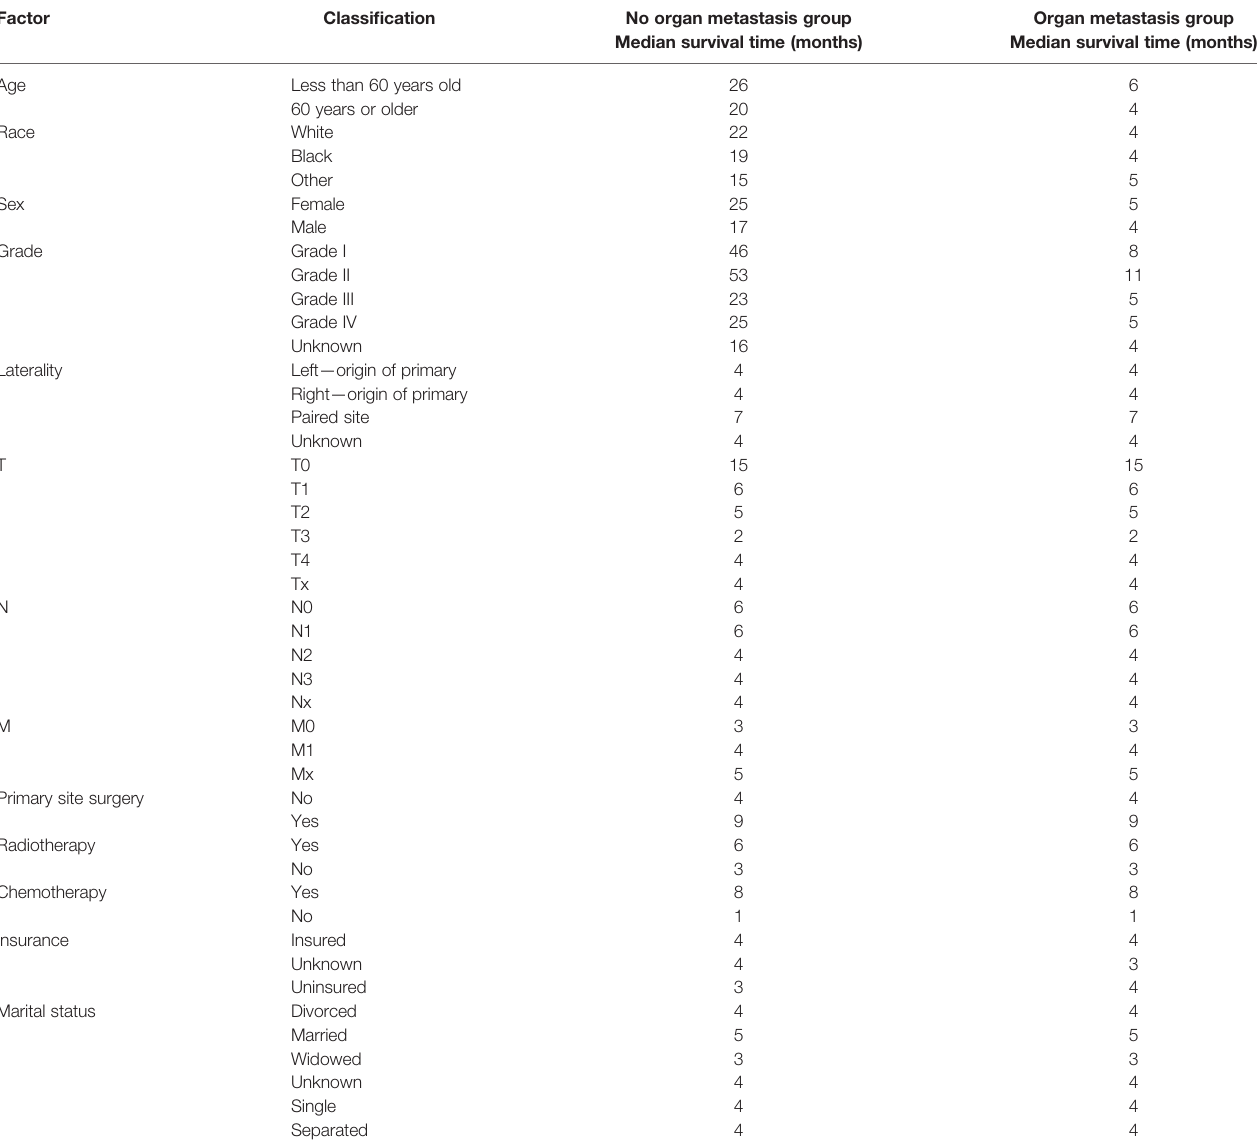
TABLE 7 | Median survival time comparison. Factor Classi fi